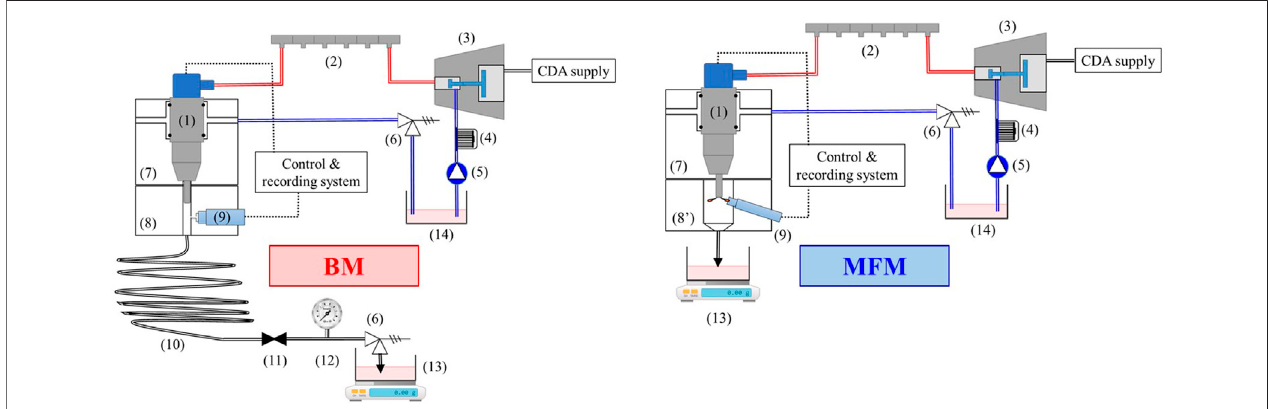
FIGURE 1 | Schematic of the BM and MFM experimental setups. List of main components: (1) Delphi F2 solenoid injector; (2) In-series common rail; (3) air-driven HPpump;(4)fuel fi lter;(5)LPpump;(6)pressurereliefvalve;(7)injectorholder;(8/8 ′ )pressuresensorholder;(9)pressuresensor;(10)25 mlongpipe;(11)valvere fl ecting pressure waves; (12) pressure gauge; (13) fuel scale; (14) fuel tank.